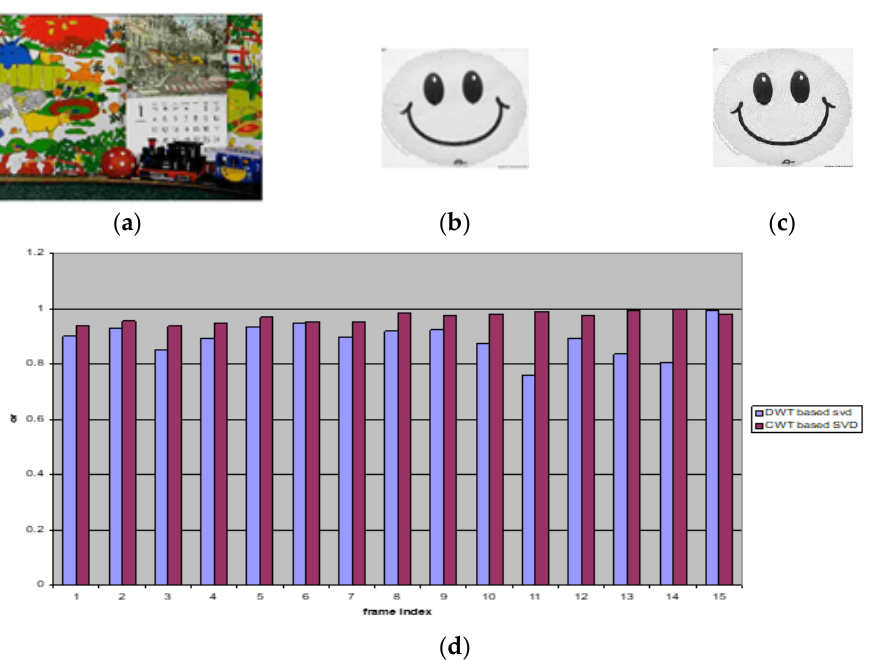
Figure 13. ( a ) The watermarked frame under compression attack using the proposed method. ( b ) Extracted watermark from frame 10 of the first video scene in the proposed method. ( c ) Extracted watermark from frame 10 of the first video scene for the DWT-based SVD method. ( d ) Correlation values for the extracted watermarks for frames 1 to 15 in the first video scene under compression attack.